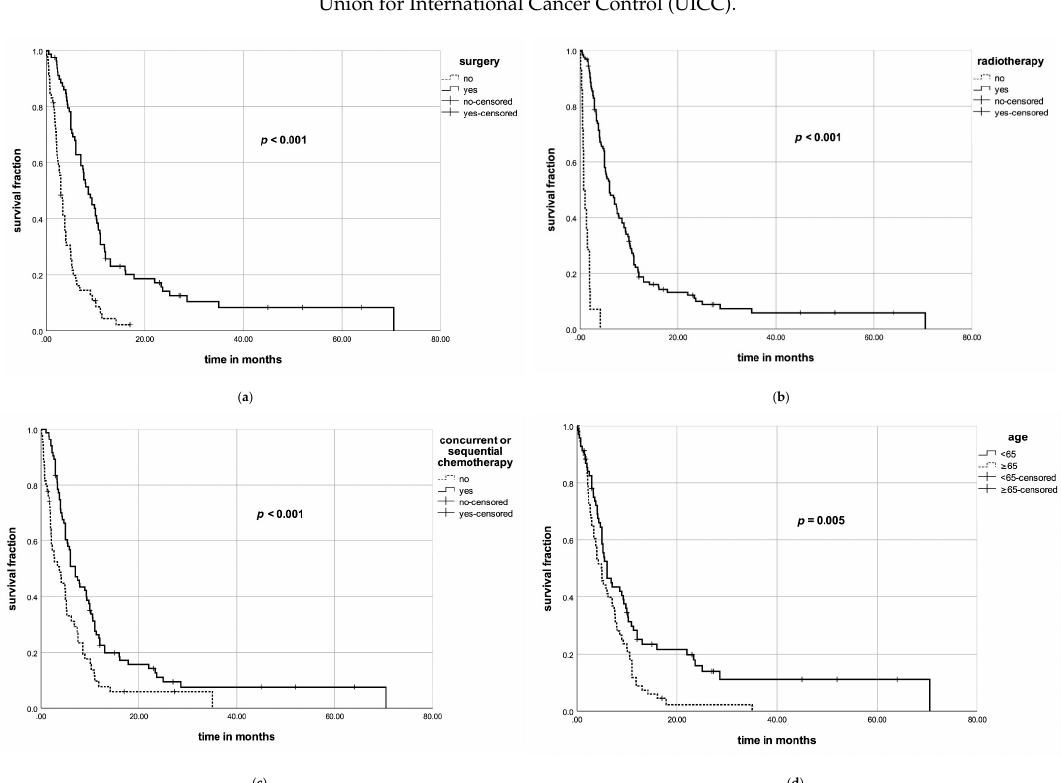
Figure 2. ( a ). Kaplan–Meier curve for surgery and overall survival in the univariate propensity score matching (PSM) analysis; ( b ) Kaplan–Meier curve for radiotherapy and overall survival in the univariate PSM analysis; ( c ) Kaplan–Meier curve for sequential or concurrent chemotherapy and overall survival in the univariate PSM analysis; ( d ) Kaplan–Meier curve for age and overall survival in the univariate PSM analysis.